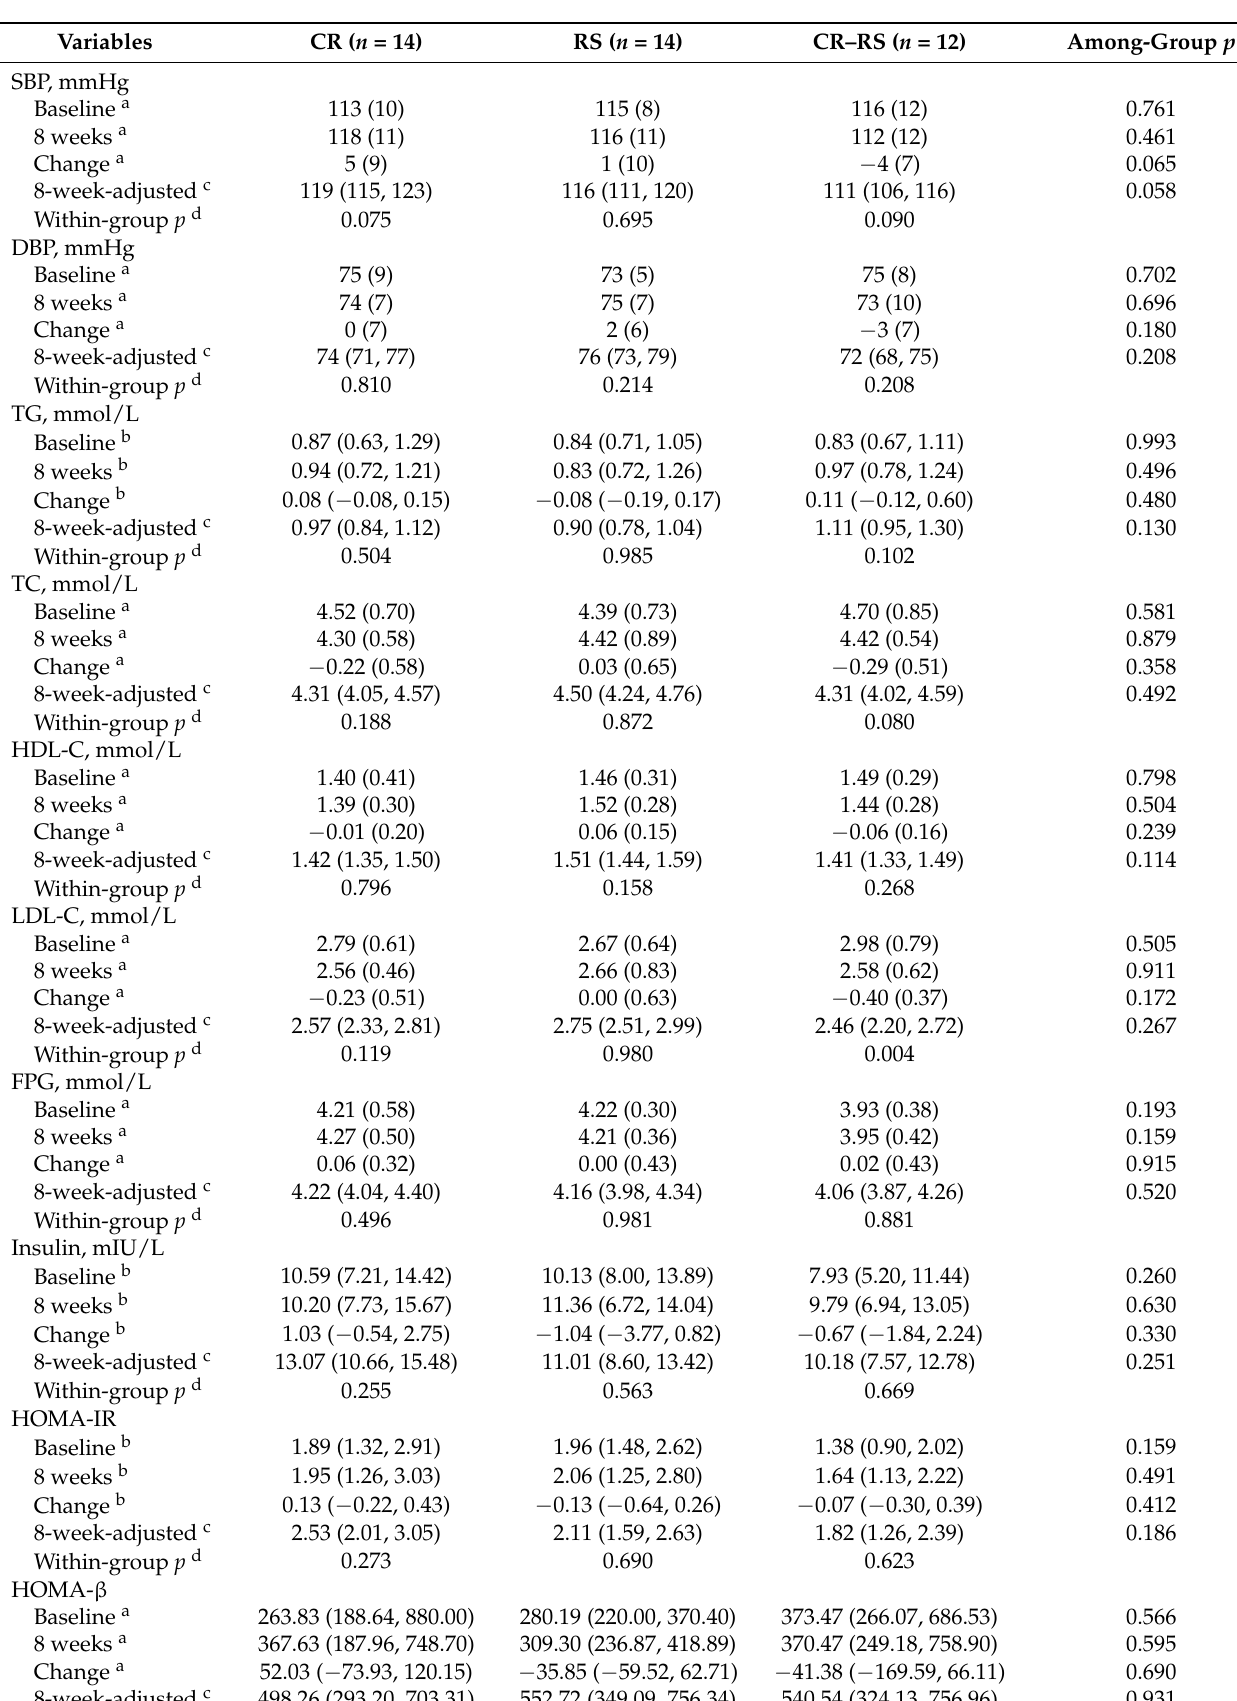
Table 3. Intervention effects on metabolic risk